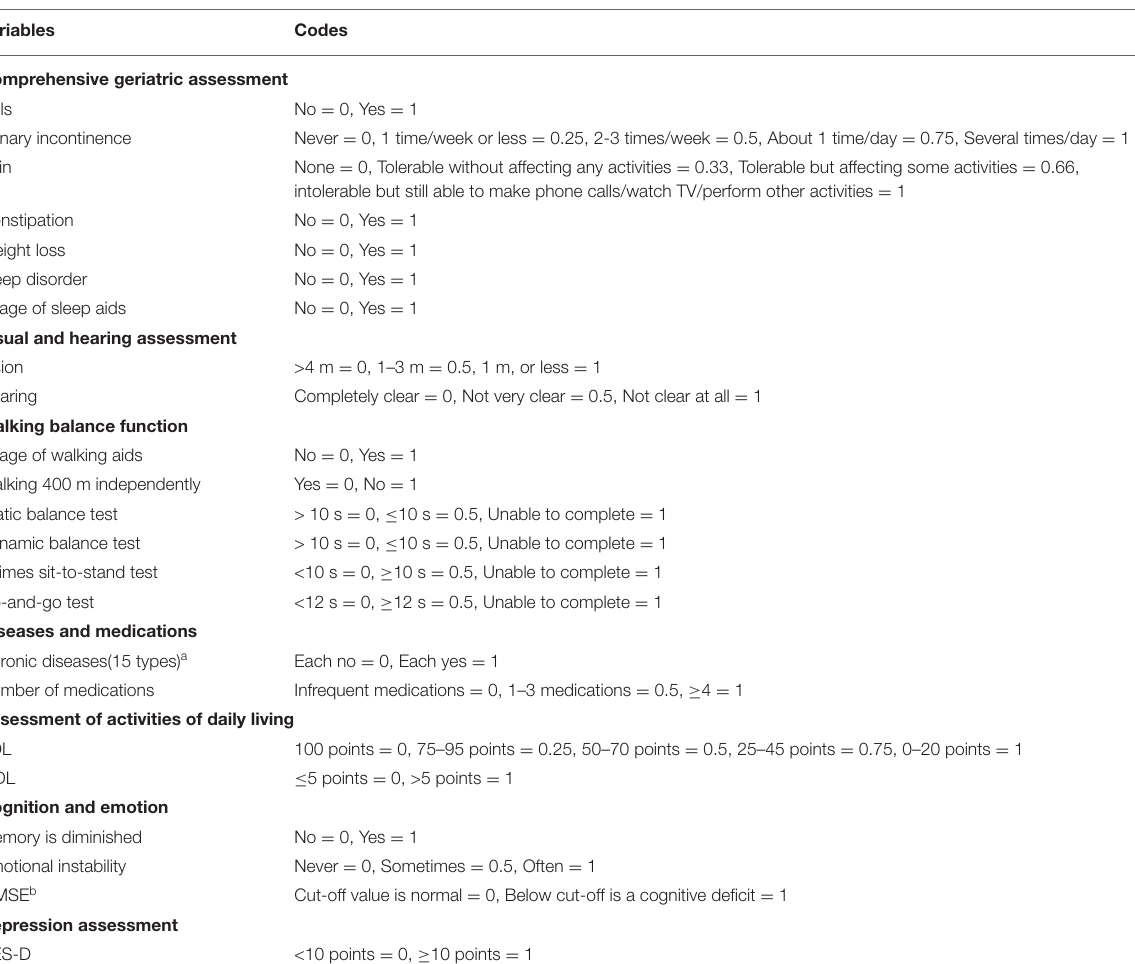
TABLE A1 | Variables for calculating the frailty index and their